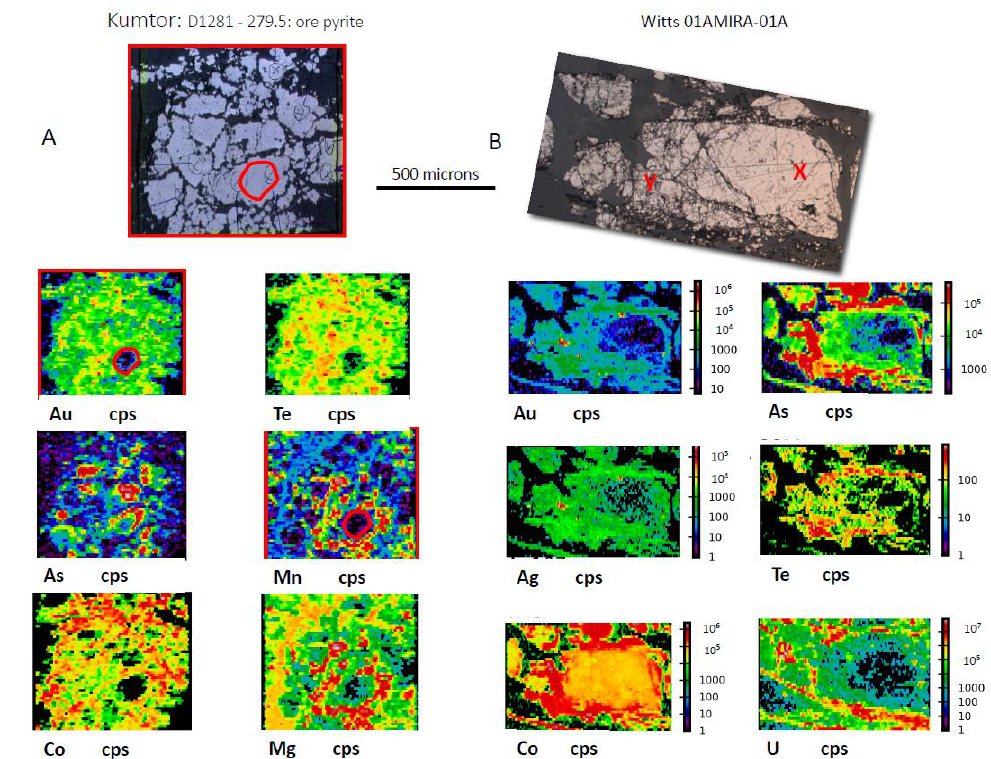
Figure 9. Gold in fractured pyrite. ( A ) LA-ICPMS maps in cps of fractured pyrite from the Kumtor deposit, Kyrgyzstan. Invisible Au-Te is indicated by the green and yellow, whereas orange and red indicate locations of nano- to micro-inclusions of Au tellurides. Arsenic is rimming some pyrite fragments. Mn and Mg suggest an initial core of Mn-carbonate was replaced by pyrite. ( B ) Fractured and brecciated pyrite from the Witwatersrand CLR. LA-ICPMS maps in cps. The intensely brecciated pyrite shows elevated invisible Au, As, Ag, Te, Co and U, suggesting that these elements were added to the pyrite during a later hydrothermal event. Corresponding red spots on the Au and Ag maps indicate the position of free electrum. Red X marks unfractured pyrite and red Y fractured